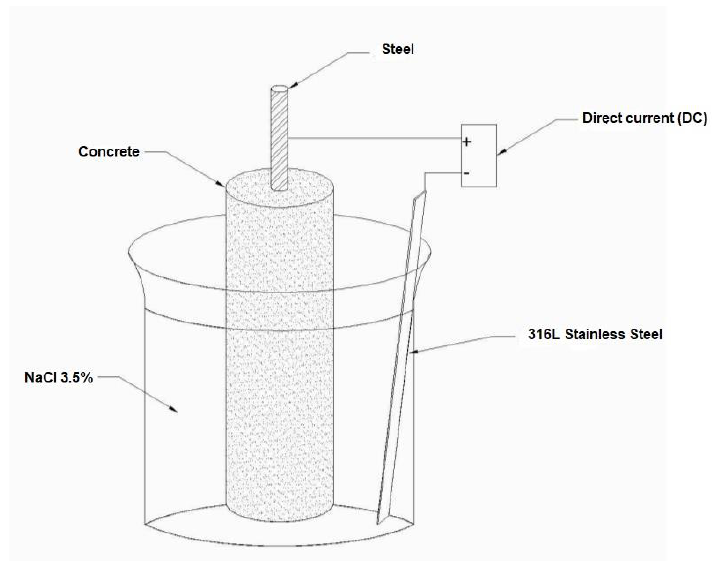
Figure 2. Impressed Voltage test setup.